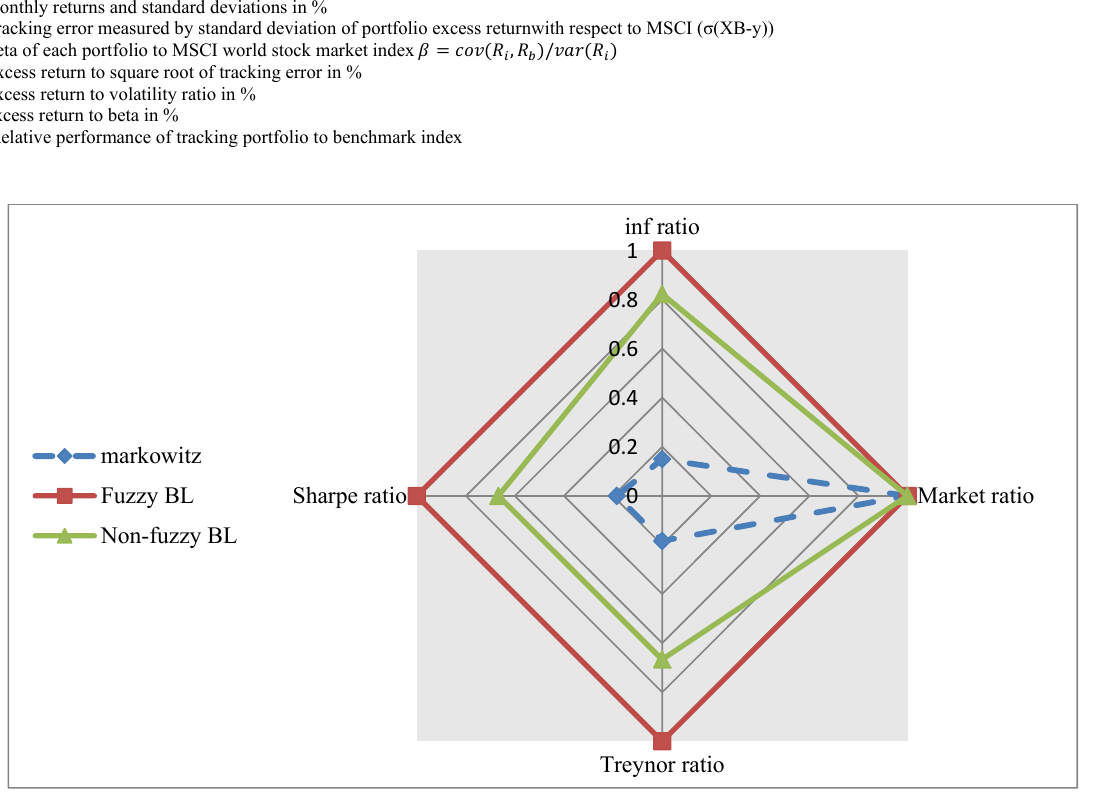
Information Sharpe Beta c ratio d ratio f